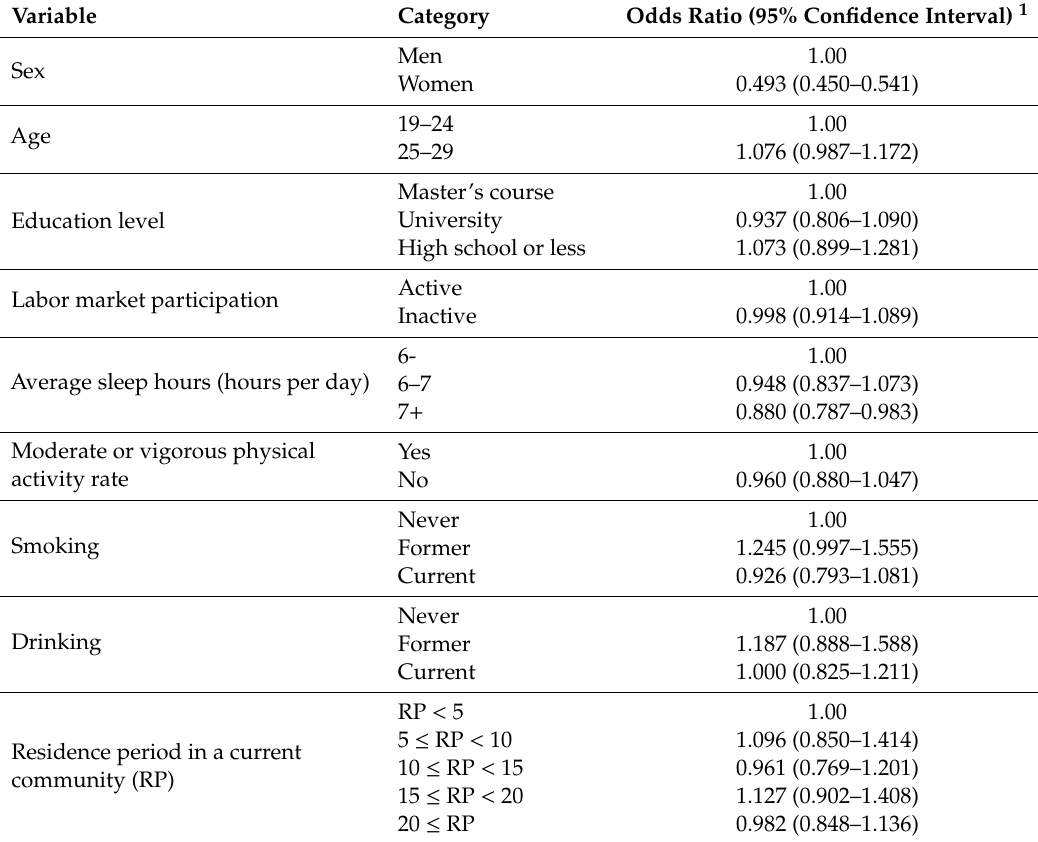
Table 2. Results of logistic regression of obesity with variables considered among young adults in Seoul, Korea,